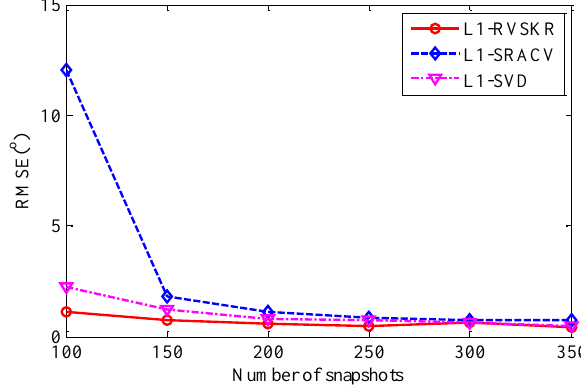
Figure 5. RMSE versus the number of snapshots.